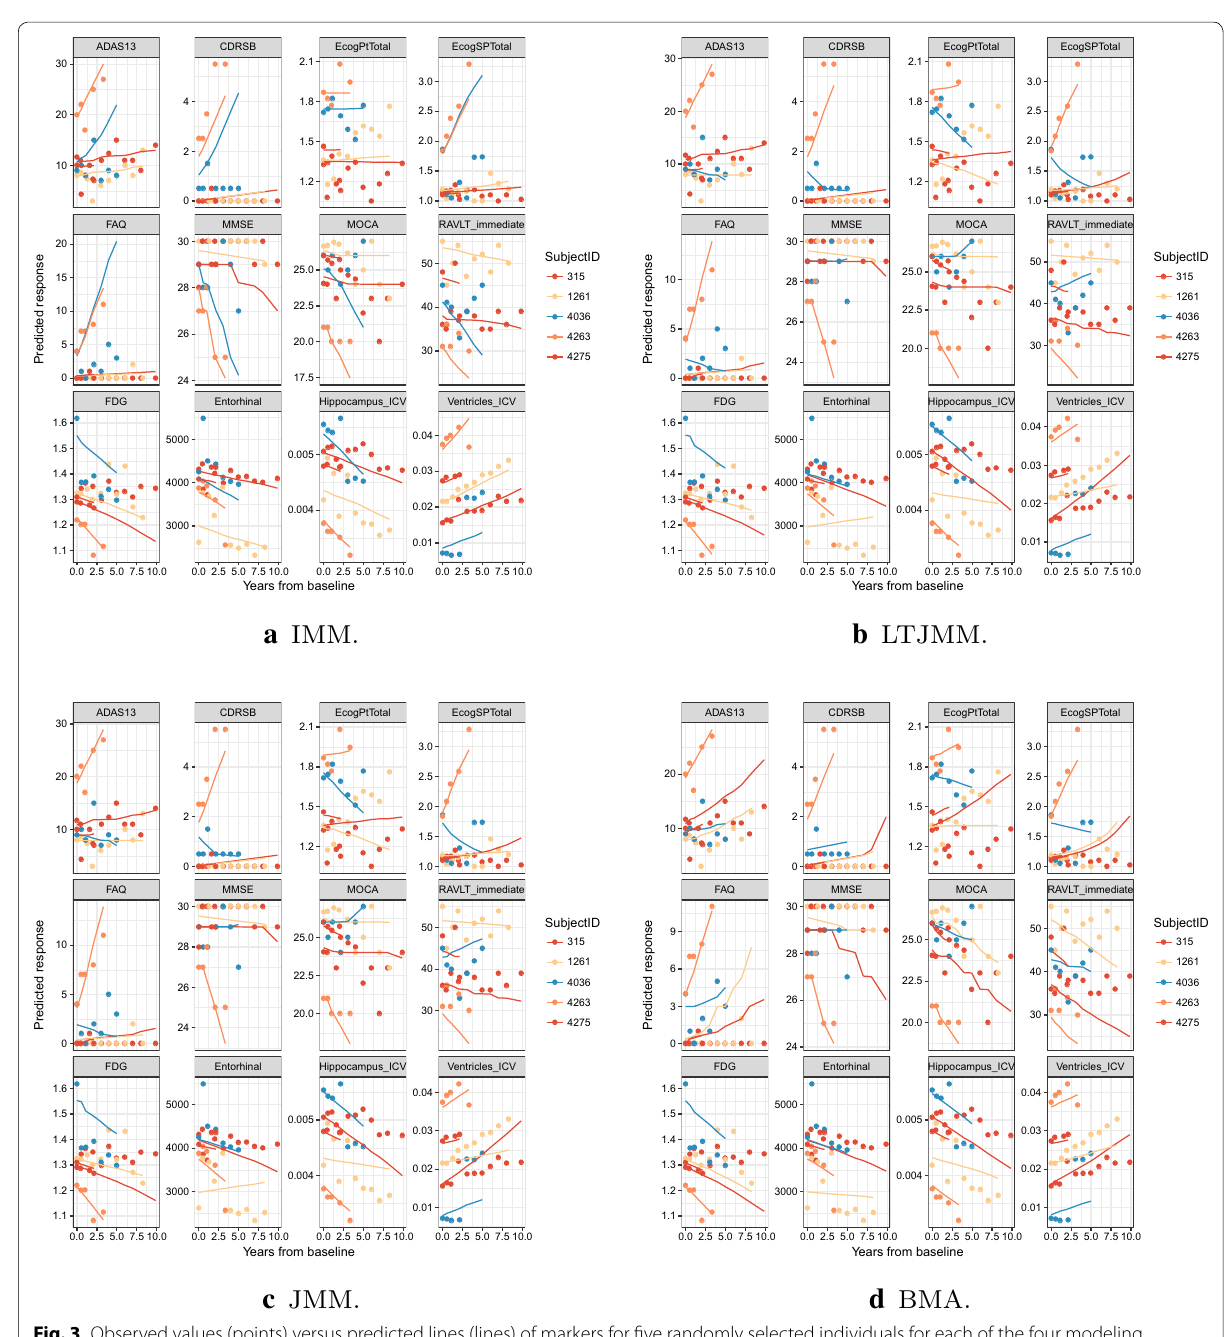
Fig. 3 Observed values (points) versus predicted lines (lines) of markers for five randomly selected individuals for each of the four modeling approaches. IMM Independent mixed-effects model, JMM joint mixed-effects model, LTJMM latent-time joint mixed-effects model, BMA Bayesian model averaging, ADAS13 Alzheimer’s Disease Assessment Scale, CDRSB Clinical Dementia Rating—Sum of Boxes, EcogPtTotal everyday cognition participant, EcogSPTotal everyday cognition study partner, FAQ Functional Assessment Questionnaire, FDG FluoroDeoxyGlucose, MMSE Mini-Mental State Examination, MOCA Montreal Cognitive Assessment, RAVLT Rey Auditory Verbal Learning Test, ICV intracranial